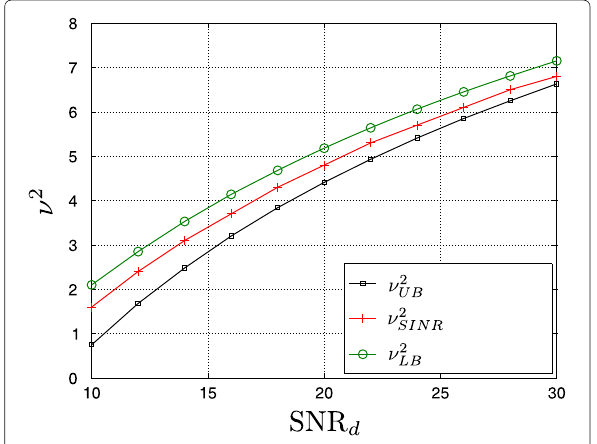
Fig. 3 The result of the numerical maximization of SINR ν 2 , and the lower bound ν 2 upper bound ν 2 UB for the SL model and a Rayleigh relay-destination